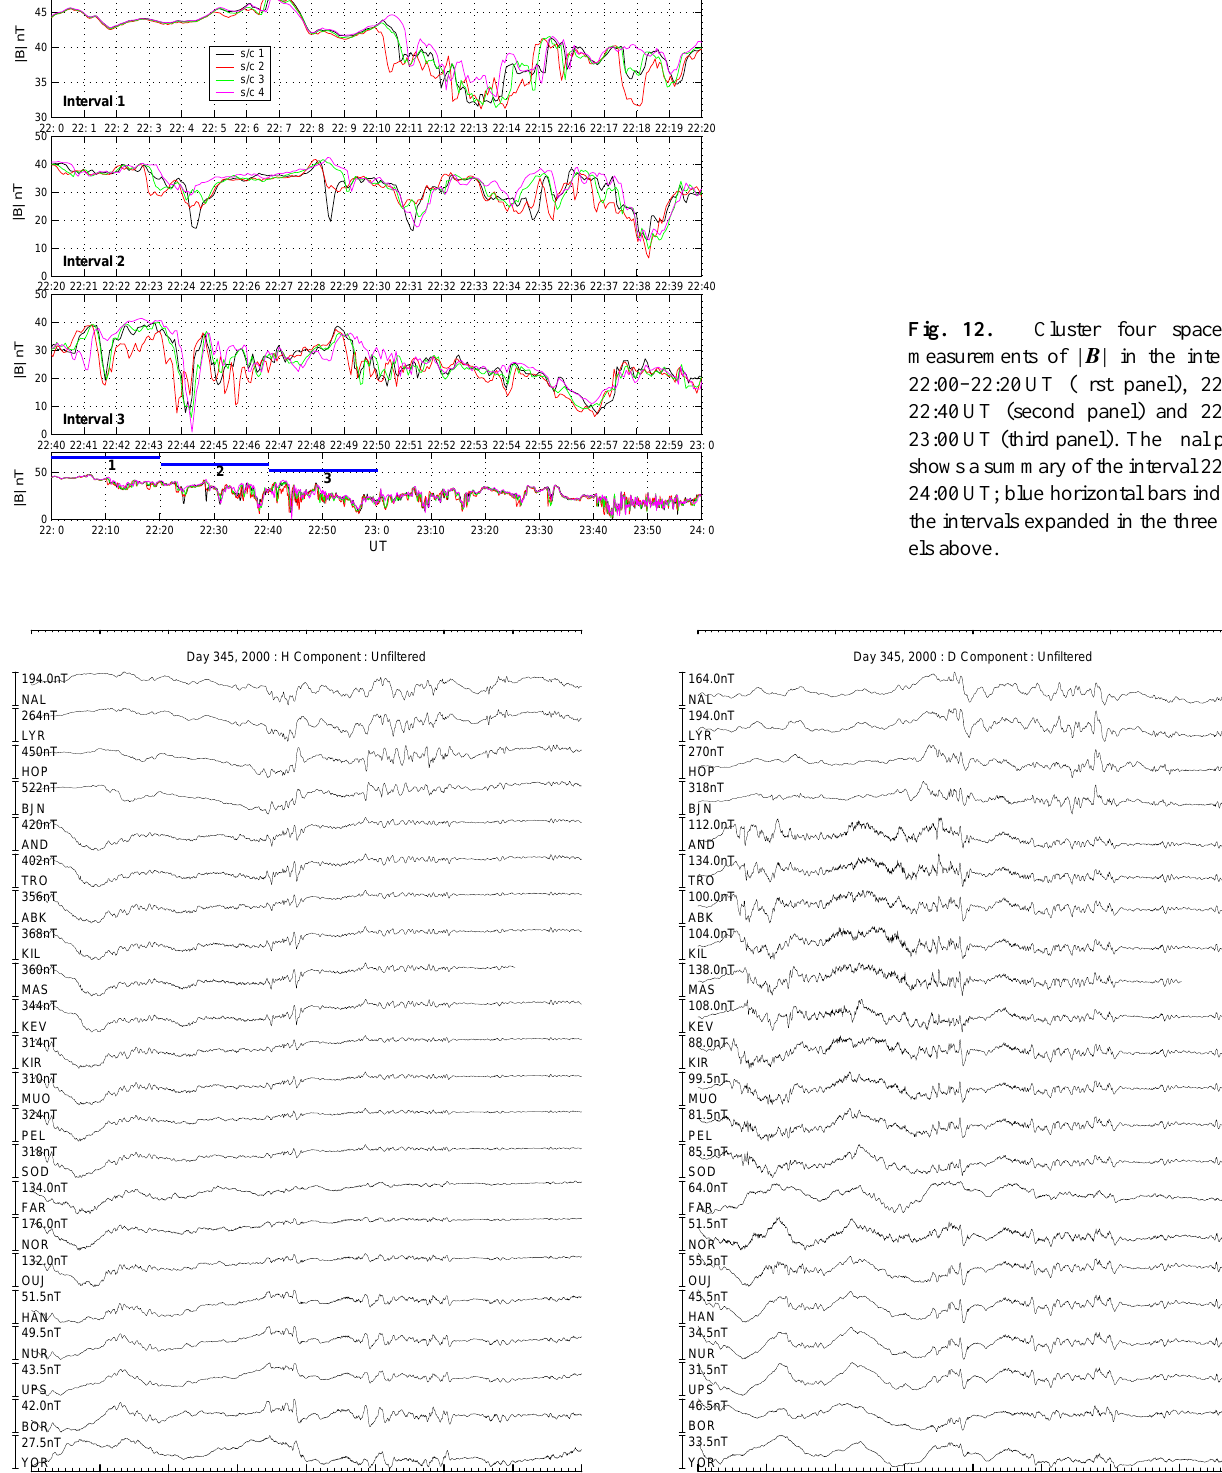
Fig. 13. Stacked H -component (a) and D -component (b) magnetograms from selected IMAGE and SAMNET magnetometer stations between 00:00UT and 08:00UT on 10 December 2000. Each magnetogram is independently scaled, the amplitude being indicated by the bars on the left hand side of each